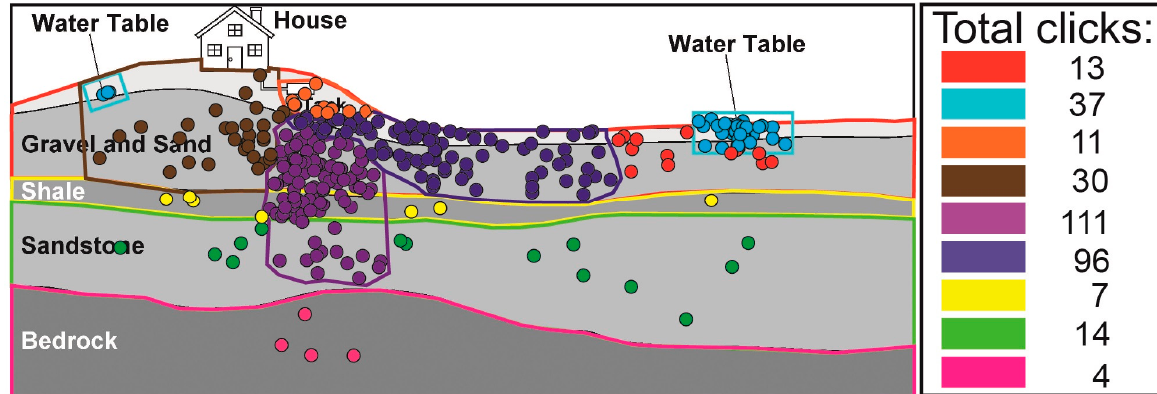
Figure 4. Polygons and student clicks in response to the prompt, “The septic tank under the house leaks for a week before being repaired. Click where you expect to find the pollution in a month”. The correct region, labeled in dark purple ( n = 96), includes vertical and horizontal flow associated with gravity and topography, respectively. The light purple region encompasses only vertical groundwater flow (gravity) ( n = 111). Other regions were bounded based on clusters of student responses and natural breaks in the data.